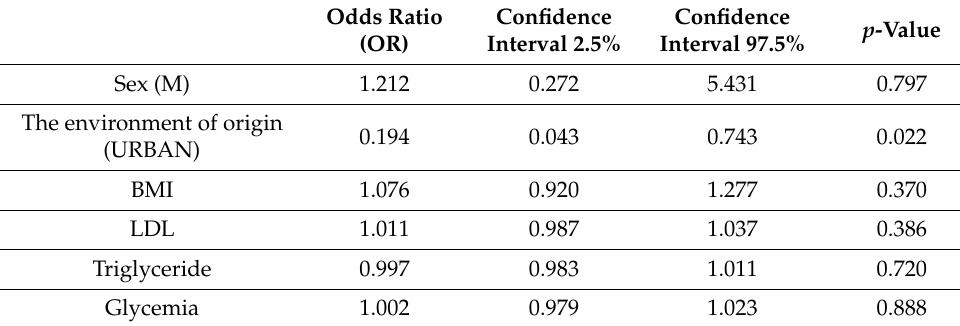
Table 2. Binomial logistic regression model for bilateral KOA affection.